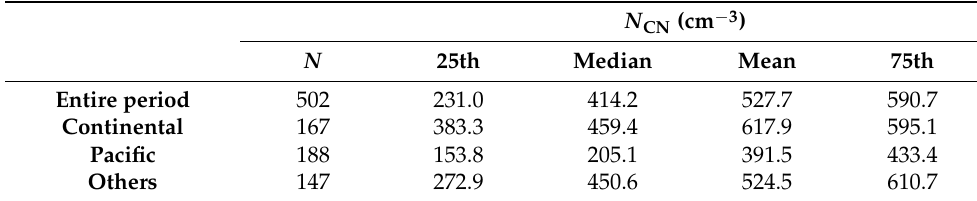
Table 1. The 25th percentile, median, mean and 75th percentile values of N CN . Number of data ( N ) for each air mass category is also indicated.